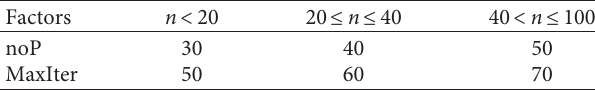
Table 4: Parameters used in EX-PSO-EX.